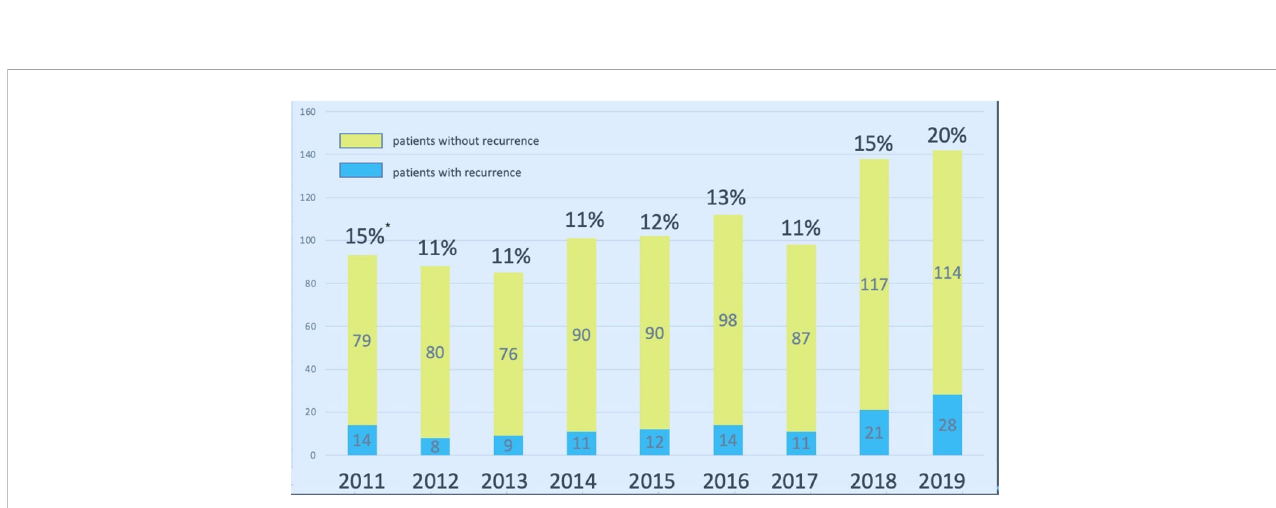
FIGURE 2 Surgical volume of parathyroidectomy for SHPT at Linkou Chang Gung Memorial Hospital from, 2011 to, 2019. * indicates the percentage of repeated parathyroidectomy for patients with recurrent SHPT. SHPT, secondary